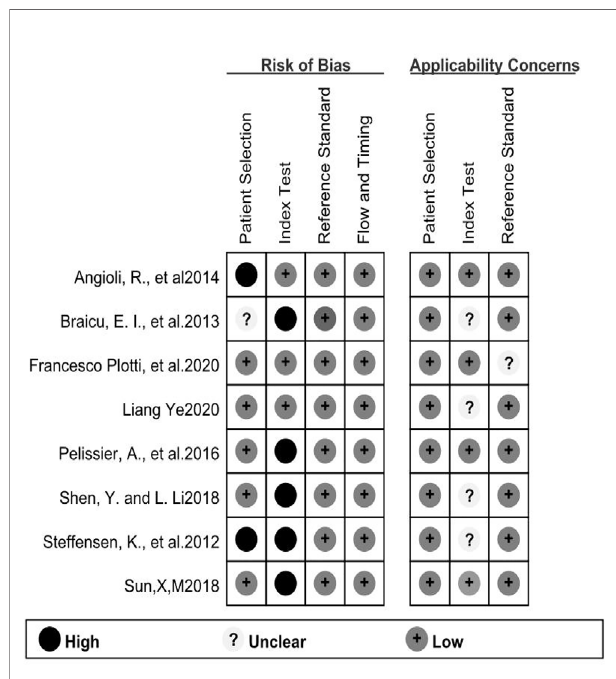
FIGURE 2 | The tabular presentation of QUADS-2